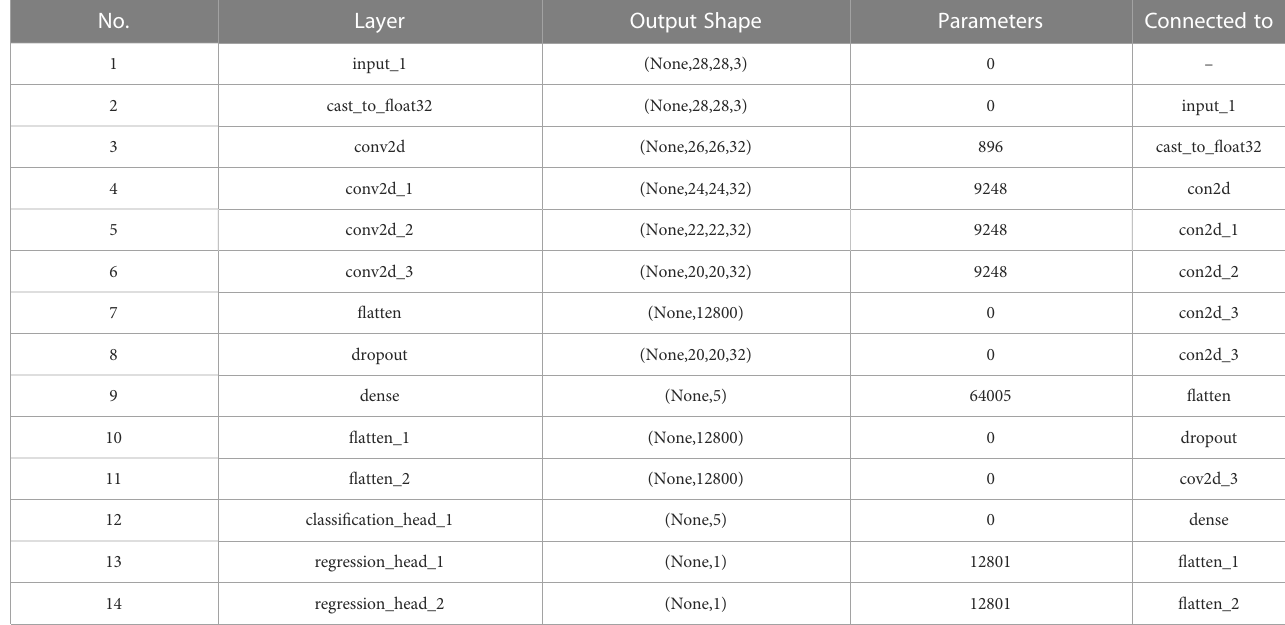
TABLE 2 Network parameters of the trained and selected model shown in Figure 5 generated by AutoML for Arabidopsis thaliana phenotype reasoning. No.